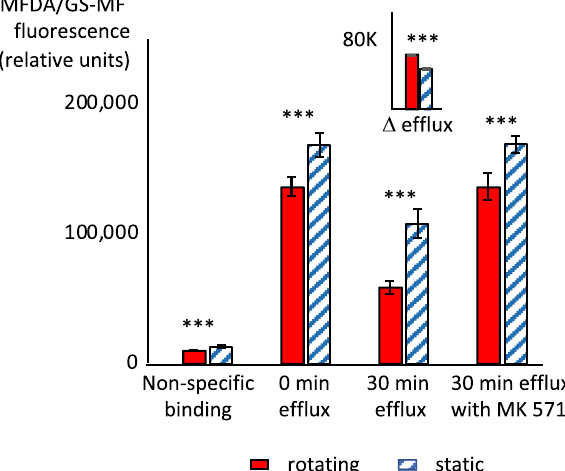
Figure 7. Effect of rotation in cell spinpods on the activity of xenobiotic efflux transporters. RPTEC/TERT1 cells on Cytodex carrier beads were cultured in cell spinpods under rotating ( ) or static conditions ( ) for 48 h and harvested. One aliquot of cells was chilled and cold CMFDA was added before immediate analysis to measure non-specific binding. The remaining cells were incubated with CMFDA for 40 min at 37 °C, washed, and the CMFDA/GM-SF was allowed to efflux in the presence and absence of the inhibitor MK571. The quantity of CMFDA/GS-MF in the cells was measured by flow cytometry immediately after washing (0 min efflux) and after 30 min of efflux at 37 °C (30 min efflux and 30 min efflux with MK 571). Asterisks indicate where differences in the distributions between groups were statistically significant, e.g. p < 0.05, by one-tailed Mann–Whitney U test. Non-specific binding was significantly higher in cells from rotating cell spinpods ( p = 0.00015, W = 2, n 1 = n 2 = 5). CMFDA/GS-MF remaining in cells from rotating cell spinpods was significantly lower at time zero ( W = 4, n 1 = n 2 = 6, p = 0.013), after 30 min of efflux ( p = 0.00035, W = 0, n 1 = n 2 = 5), and after 30 min of efflux in the presence of MK571 ( p = 0.065, W = 6, n 1 = n 2 = 6). The inset shows the difference